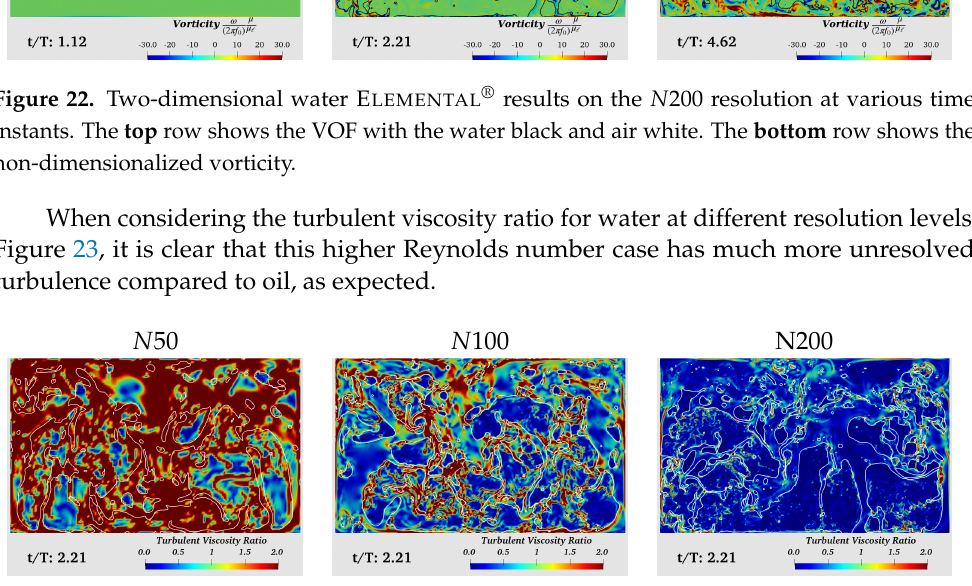
Figure 23. Two-dimensional water E LEMENTAL ® turbulent viscosity ratio at different resolutions at t = 2.21 T